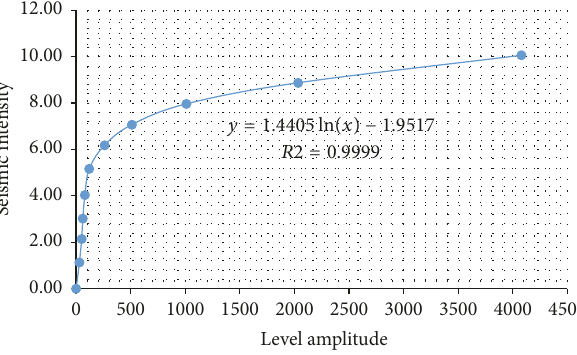
Figure 6: Intensity versus level amplitude.